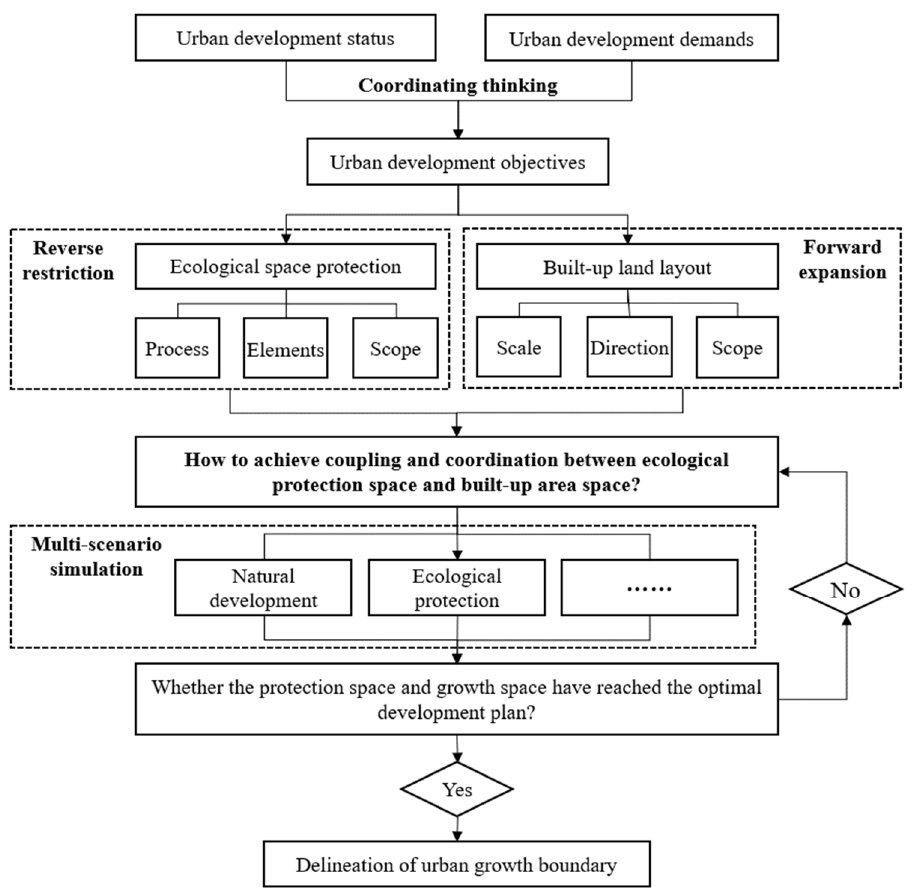
Figure 7. Research framework of urban growth boundary based on multi-scenario planning.